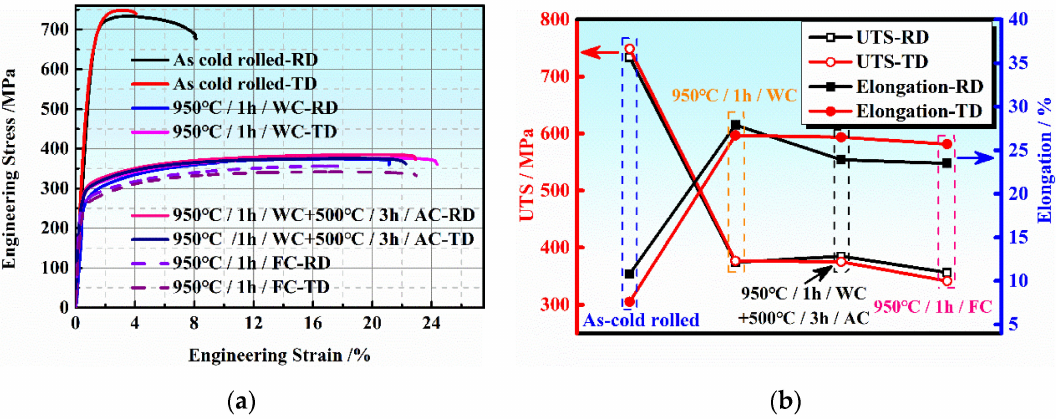
Figure 2. Room temperature tensile testing results of as-cold rolled and heat treated sheets: ( a ) engineering stress-strain curves, ( b ) ultimate tensile strengths and elongations of the specimens. Table 1. Mechanical properties of as-cold rolled and heat treated sheets. Tensile Strength Yield Specimen /MPa